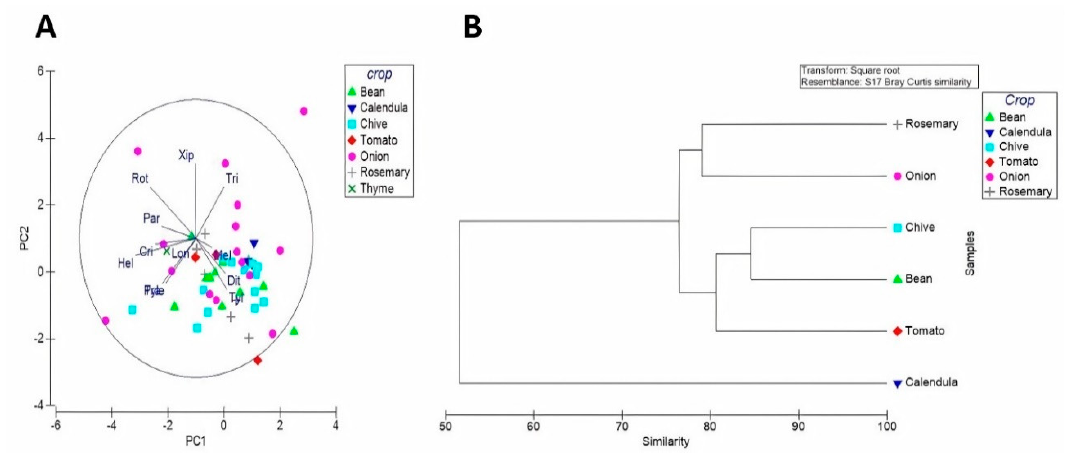
Figure 4. Organic crop patterns and their affiliation with species’ agro-ecological characteristics. ( A ) Bi-plot (Pearson type) of organic crops surveyed in interaction with PPN genera. ( B ) Hierarchical cluster analysis showing similarities between crops in terms of PPNs (square-root transformed) based on the Bray-Curtis similarity index. Nematode genera codes are given in Table 1.